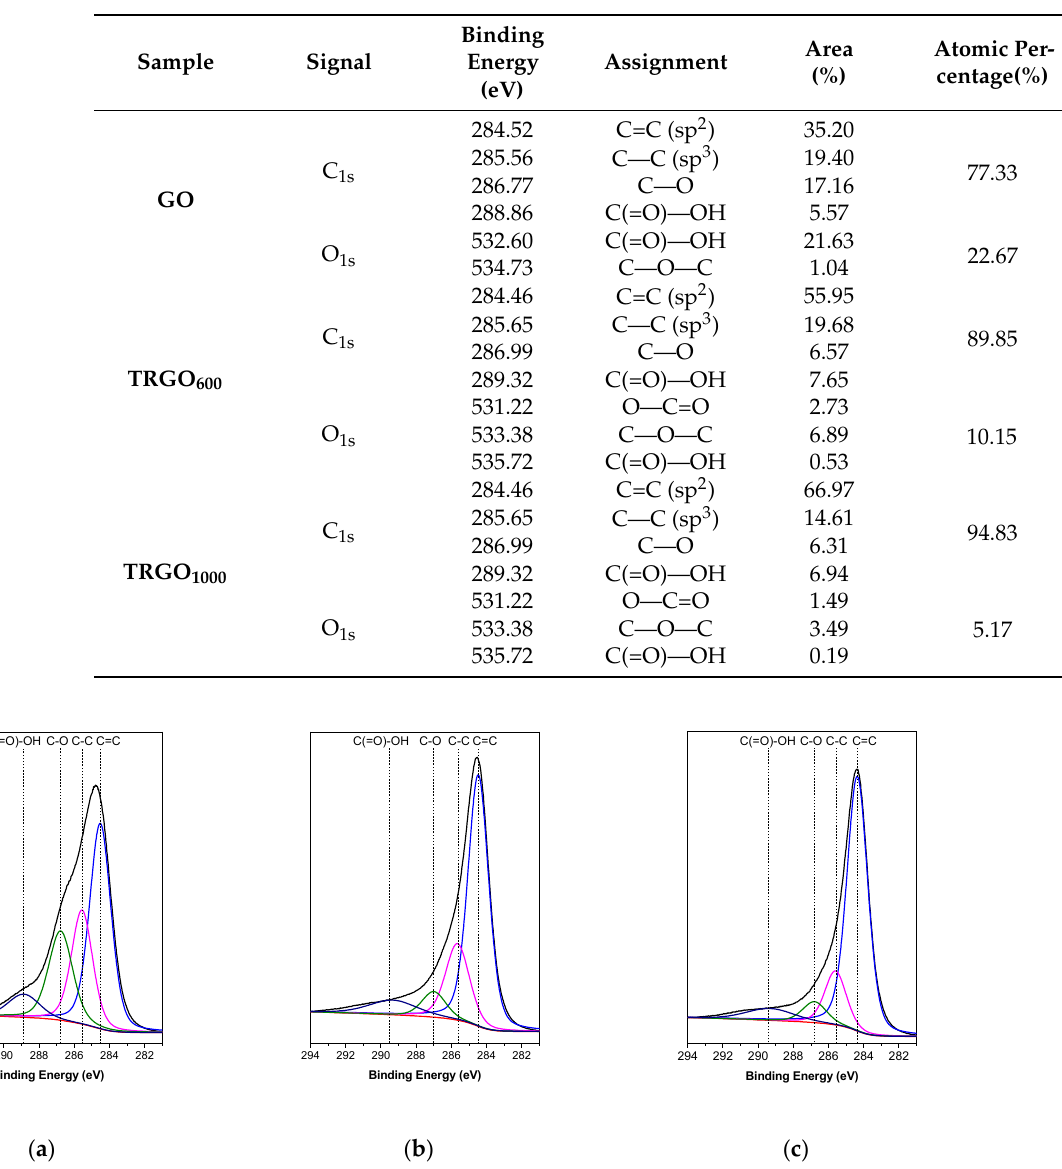
Table 3. Signal, binding energy, assignment, area percentage, and atomic percentage of GO, TRGO 600 , and TRGO 1000 obtained from X-ray photoelectron spectroscopy.